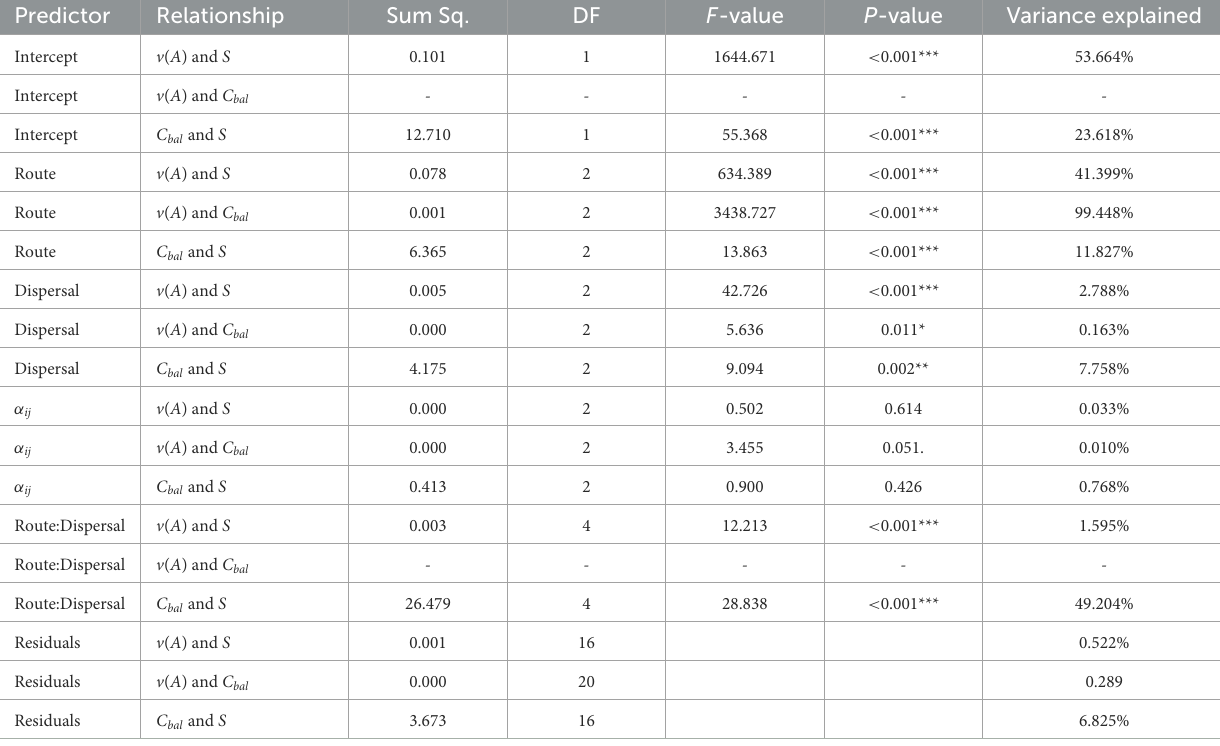
TABLE 2 Route of abiotic influence (on density, interaction strengths, or neither in the null model) was always a significant predictor of the strength of the measured relationships. Predictor Relationship Sum Sq. F -value P -value Variance